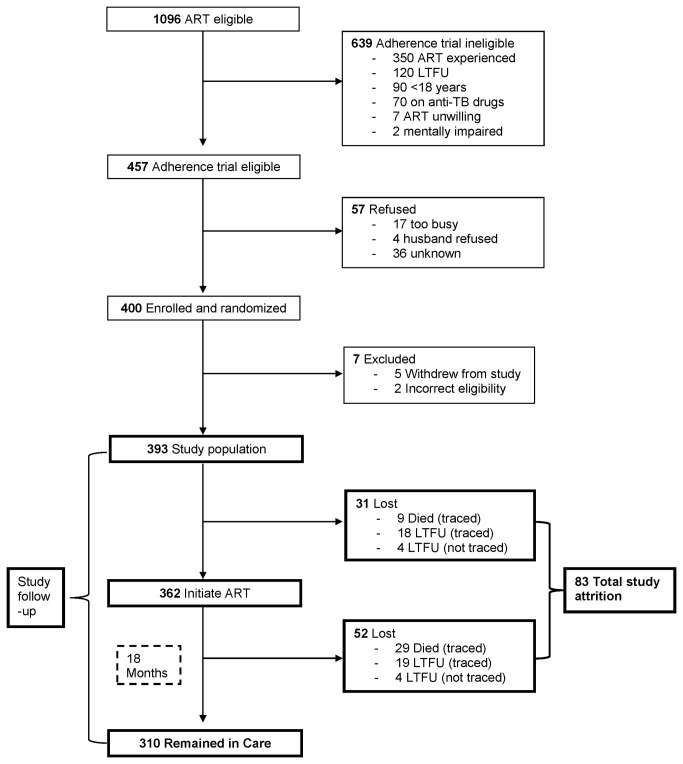
Trial profile of ART eligible patients screened at Coptic Hope Center.